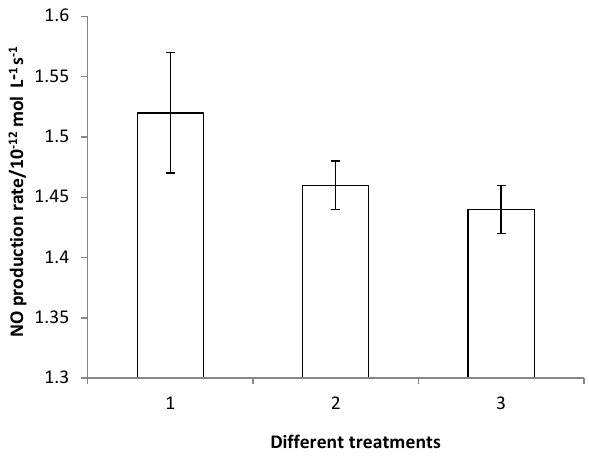
Figure 7. The production rates of NO by seawater irradiation under natural light after different treatments. Treatment 1 is seawater irra- diation at an ambient temperature of 17 ◦ C, treatment 2 is 0.45µm Millipore filtered samples, and treatment 3 is the incubation of non- filtered samples in a water bath at 13 ◦ C.